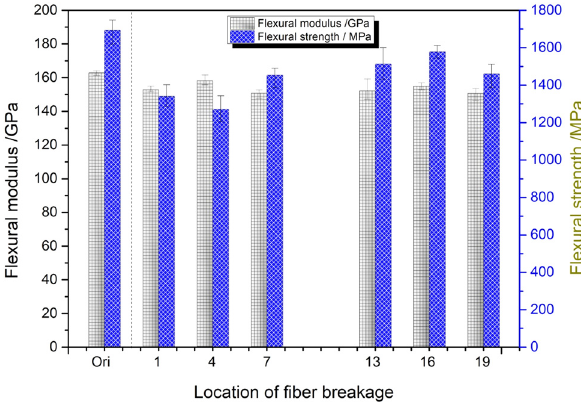
Figure 5: Flexural modulus and strength of CF/epoxy laminates with and without fiber breakage in different